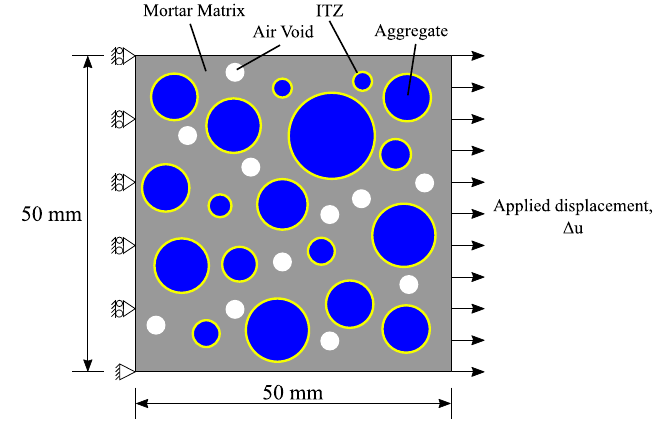
Figure 1. Schematic of mesoscale multiphase model subjected to